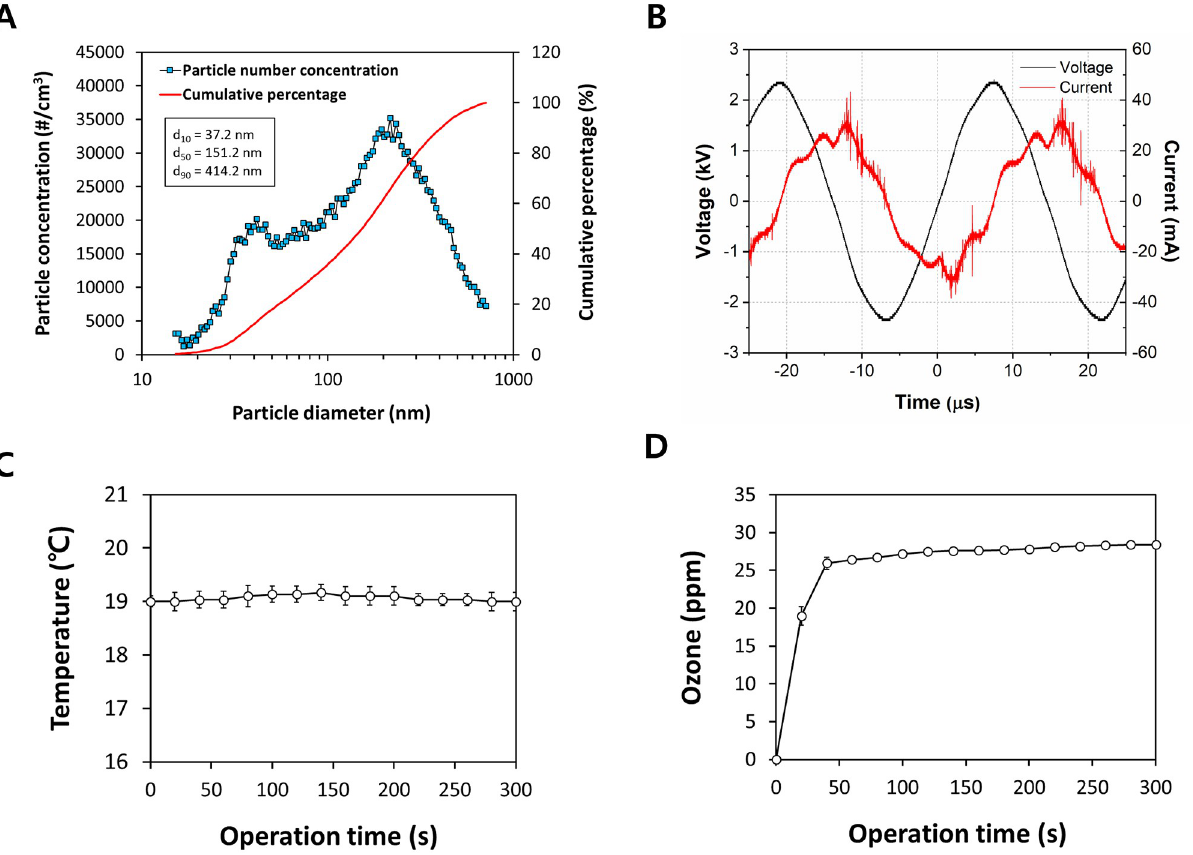
Fig 2. Physicochemical properties of the aerosol particles and dielectric filter discharge (DFD). (A) Size distribution of aerosol particles during nebulization. (B) Voltage and current waveforms, (C) temperature, and (D) ozone generation during DFD in a plasma reaction chamber. Considering the risk of the experiment, only culture medium without SARS-CoV-2 was used for the particle and system assessment.